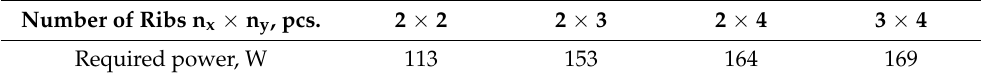
Figure 13. Panel under repair ( a ) and heat loss on its rib ( b ). Table 4. Change in the power of the heating system when the number of stiffening ribs is changed. Number of Ribs n x × n y , pcs.